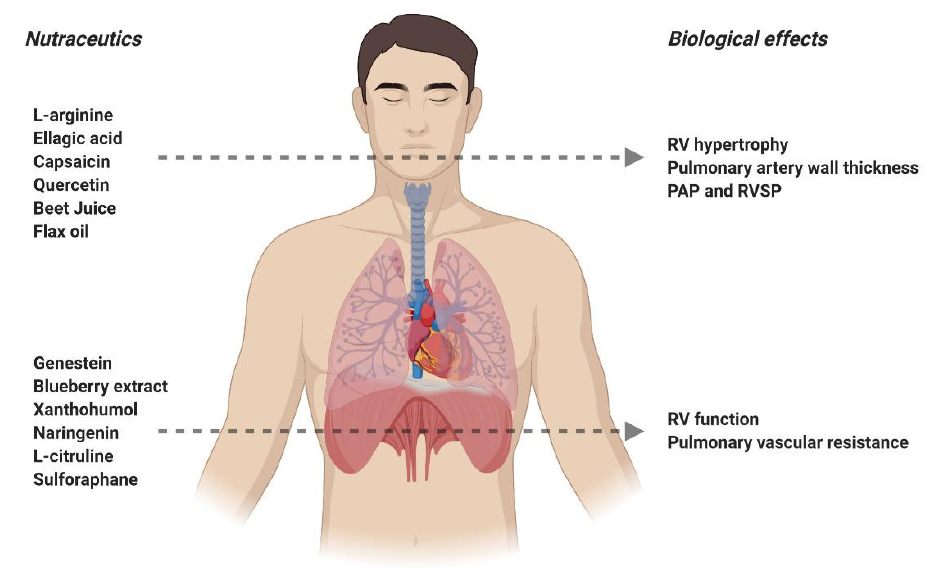
Figure 2. Biological effects of nutraceuticals. L-arginine, ellagic acid, capsaicin, quercetin, beet juice, and flax oil have a protective effect against RV hypertrophy and result in greater pulmonary arterial wall thickness and an increase in pulmonary arterial pressure (PAP) and RVSP. Figure image created with Biorender.com.